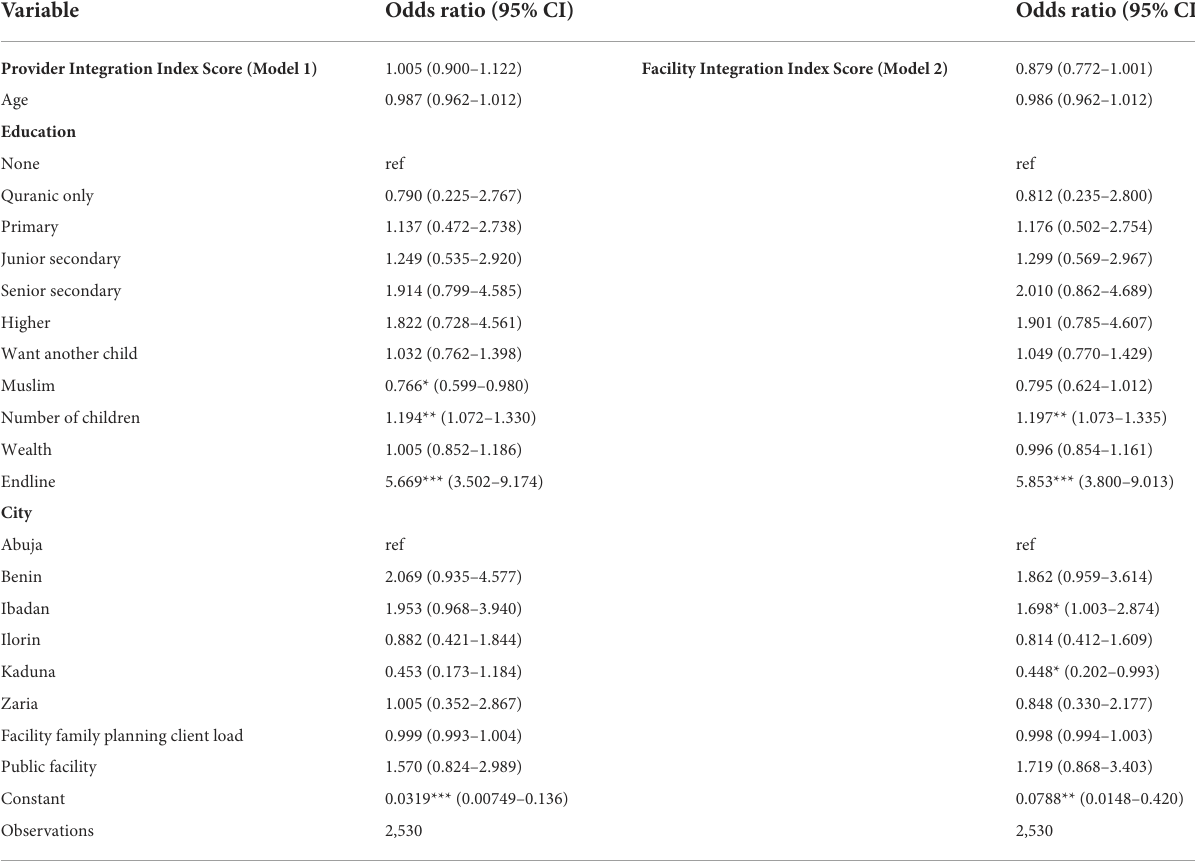
TABLE 2 Association between provider integration index and facility integration index and use of modern family planning method at time of the immunization visit.